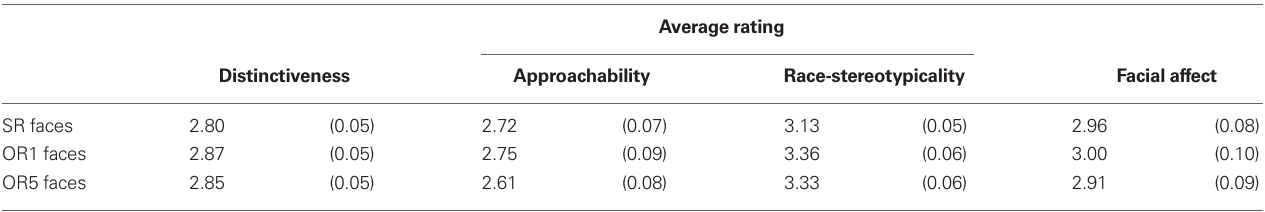
Table 2 | average rating of distinctiveness, approachability, race-stereotypicality, and facial affect assigned to faces within each